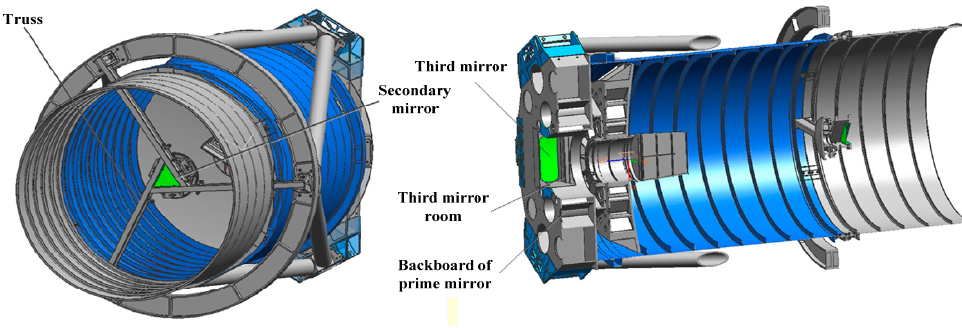
Figure 11. Camera structure. Table 4. Simulation calculation results using ground method.